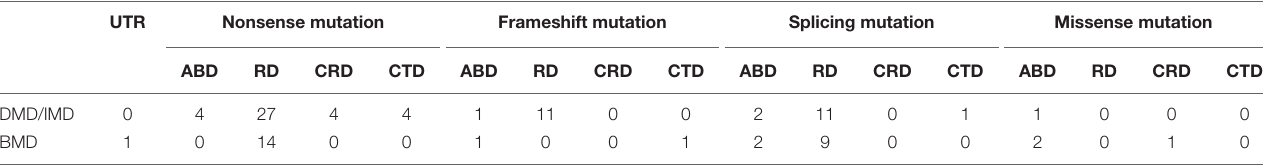
TABLE 3 | Domain distribution of mutations in DMD/IMD and BMD.